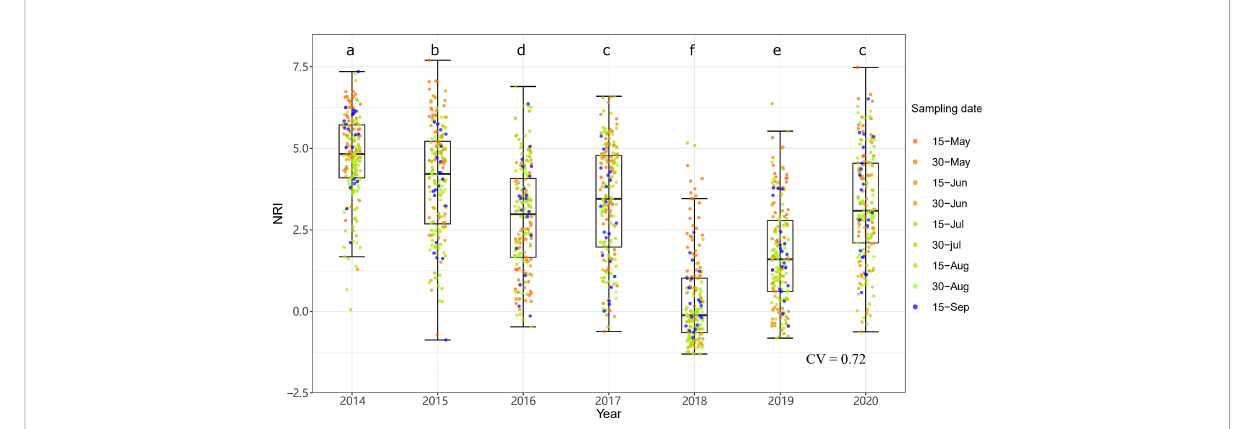
FIGURE 6 Interannual dynamics of community phylogenetic structure at the Inner Mongolia Grassland Ecosystem Research Station (ERS) in Inner Mongolia, China. The differences in the annual NRIs are denoted by different letters according to Duncan ’ s post hoc test ( p < 0.05).